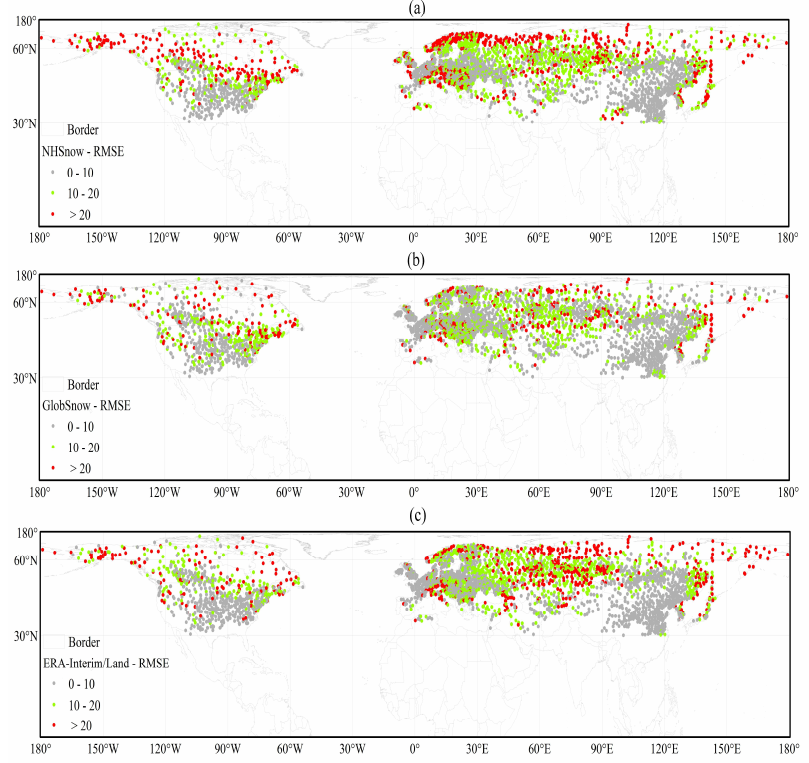
Figure 5. Root mean squire error (RMSE) of each meteorological station for three snow cover datasets: ( a ) NHSnow, ( b ) GlobSnow, and ( c ) ERA-Interim/Land. The site RMSE is calculated based on all of the valid records in each station during 1992–2010 (December to February).